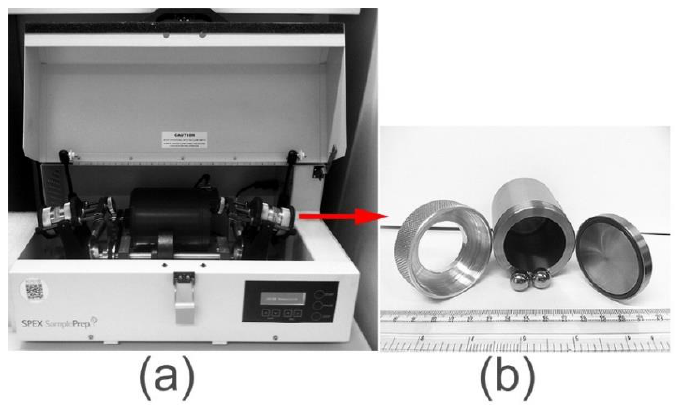
Figure 4. Photos of ( a ) SPEX8000D high energy ball mill. The milling tools (vials and balls) used of this type of ball mills are shown in ( b ). The equipment is housed in the NAP, EBRC of KISR.